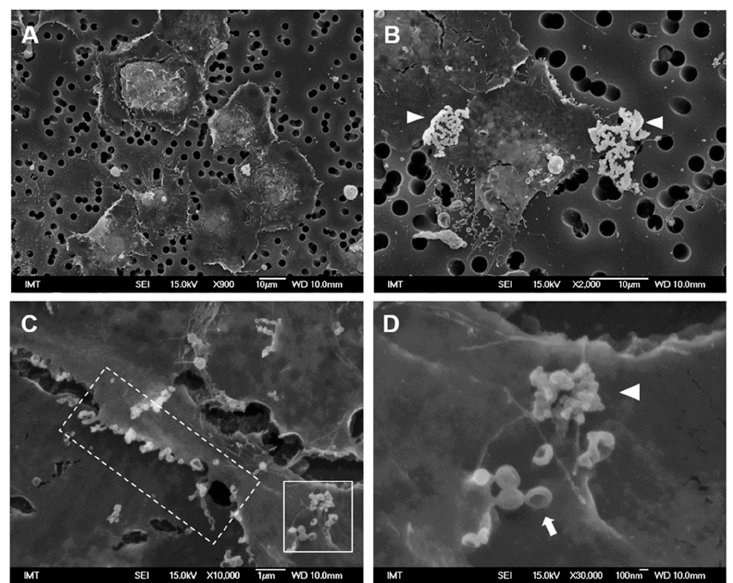
Figure 4. SEM images of M. galloprovincialis hemocytes incubated for 30 min with PS ‐ COOH suspensions (10 μ g/mL) in ASW ( A ). Arrowheads in ( B ) indicate large agglomerates of PS ‐ COOH; ( C ) short extensions and vesicles along the plasma membrane (dotted frame); ( D ) Enlargement of the white frame in ( C ) indicating the presence of PS ‐ COOH small agglomerates on the cell surface (arrowhead) as well as of concave vesicles (arrow).